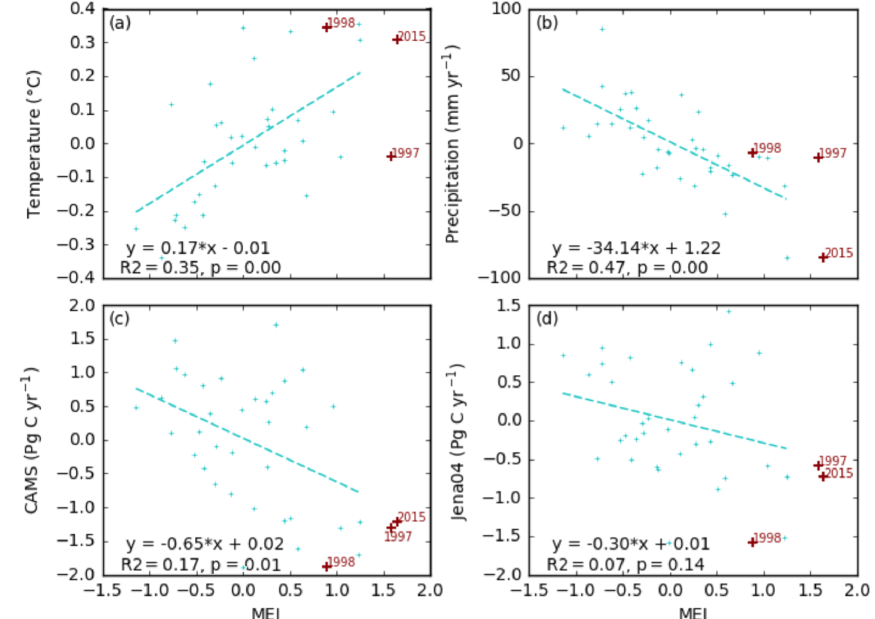
Figure 3. Relationships between anomalies of (a) land air temperature, (b) land precipitation, (c) land carbon fluxes by the CAMS inversion, (d) land carbon fluxes by the Jena04 inversion and the Multivariate ENSO Index (MEI). All variables are linearly detrended for